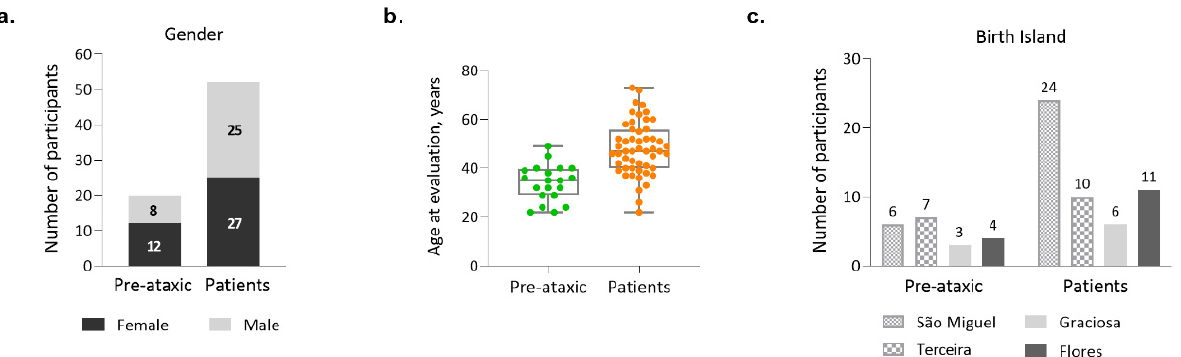
Figure 1. Demographic characterization of the Azorean MJD cohort (n = 72). ( a ) Number of pre-ataxic carriers and patients, by gender; ( b ) Age at evaluation/recruitment for pre-ataxic carriers and patients; ( c ) Number of pre-ataxic carriers and patients, by island of birth.